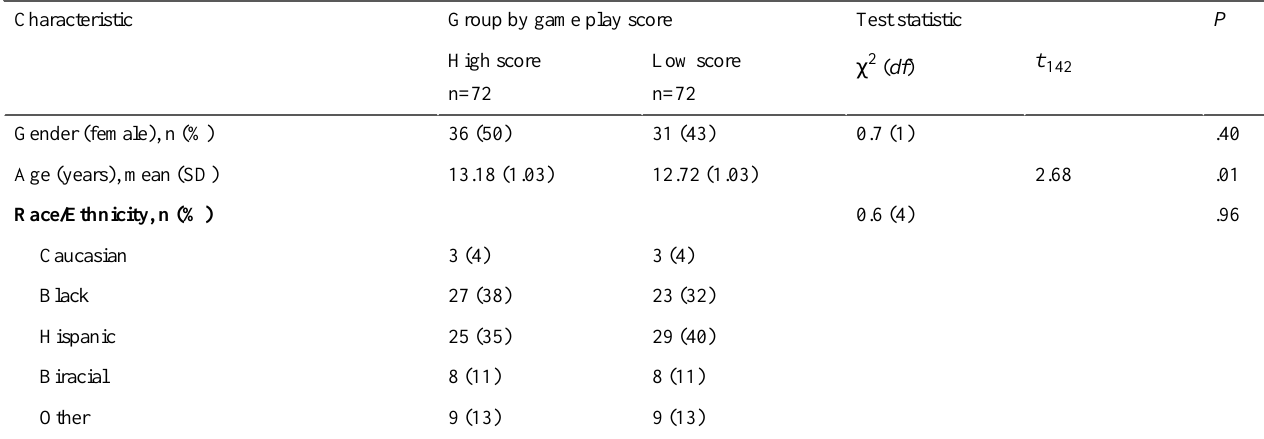
Table 1. Baseline demographic characteristics of participants (N=144).